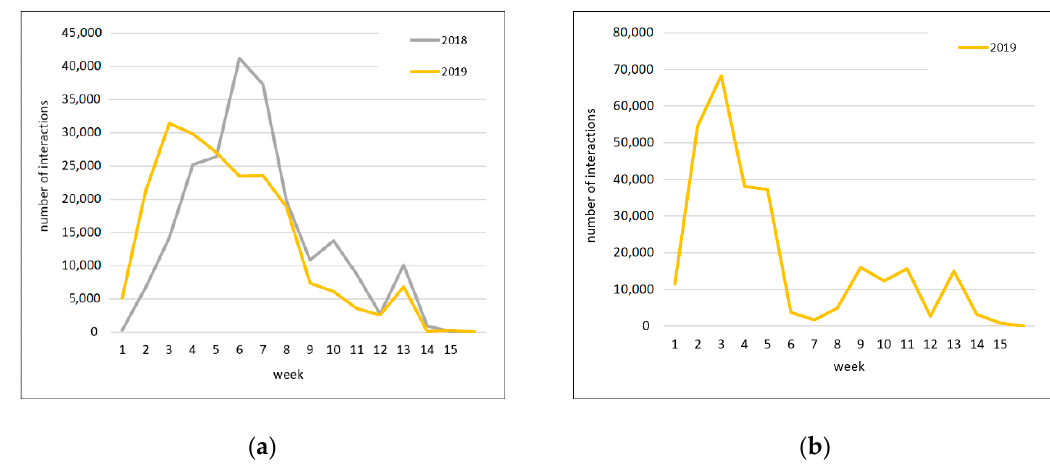
Figure 10. The interactive activities in courses 2018 and 2019 during the weeks of the semester: ( a ) automated source code evaluation activities; ( b ) microlearning activities. Table 14. Pearson correlation coe ffi cient between the test results and interactive student activities results. Group Test 1—VPL1 Test2—VPL2 Sum of